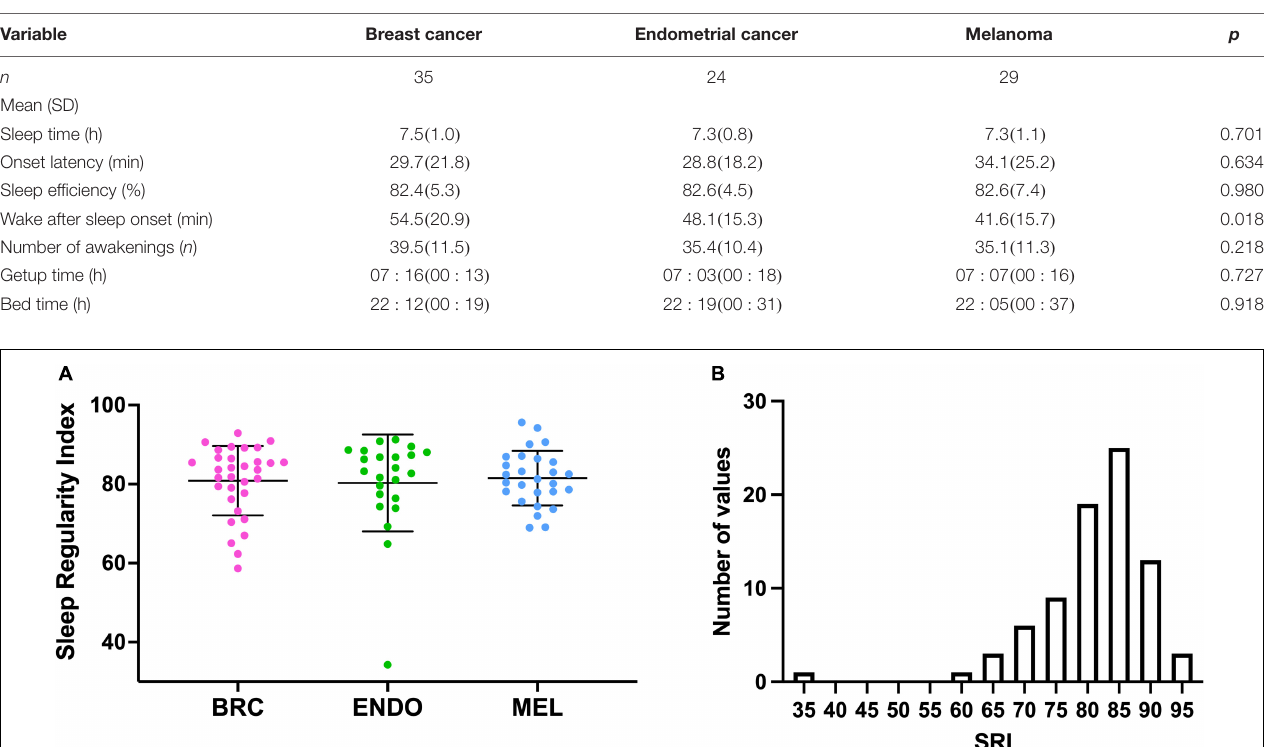
TABLE 2 | Standard actigraphy metrics.